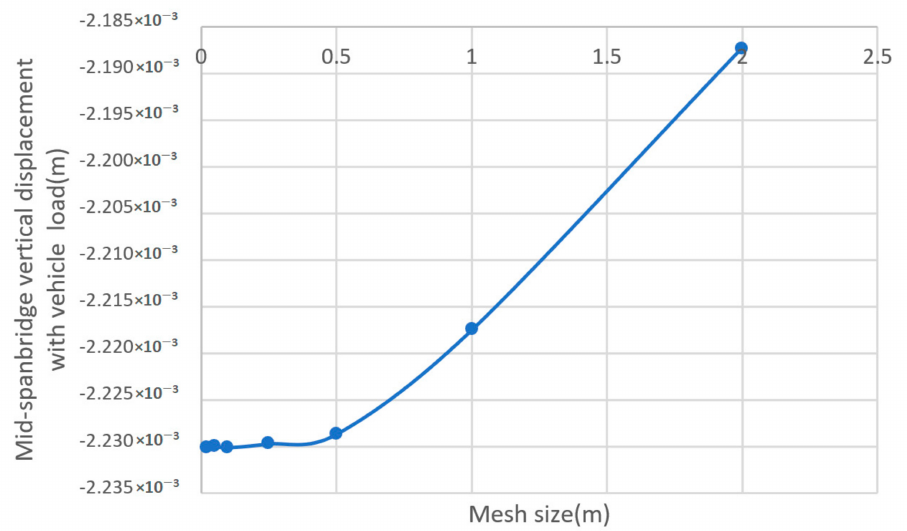
Figure 1. The convergence of mesh size on the mid-span bridge vertical